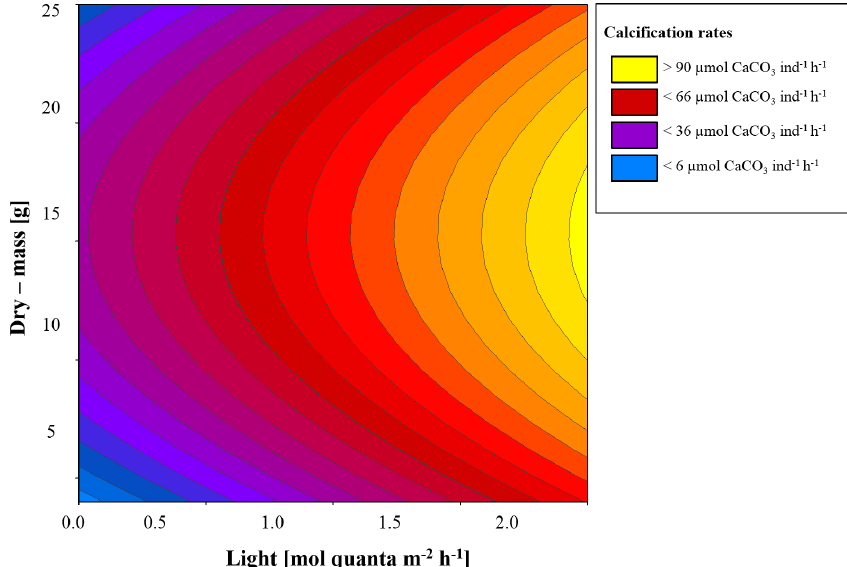
Figure 5. Model considering a linear relationship between light and calcification and a first-order polynomial relationship between dry mass (DM) and net calcification (NC) explaining 77% of the